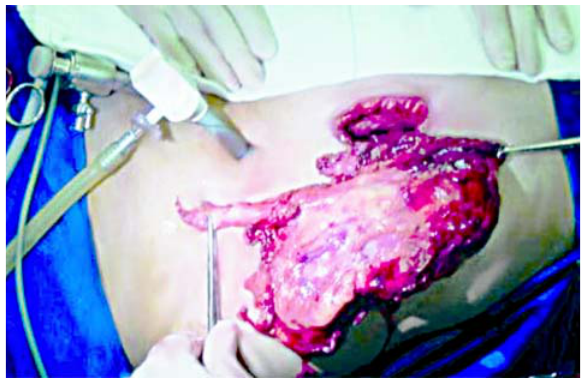
Figure 3 – Surgical specimen (pyonephrosis) removed through the manual